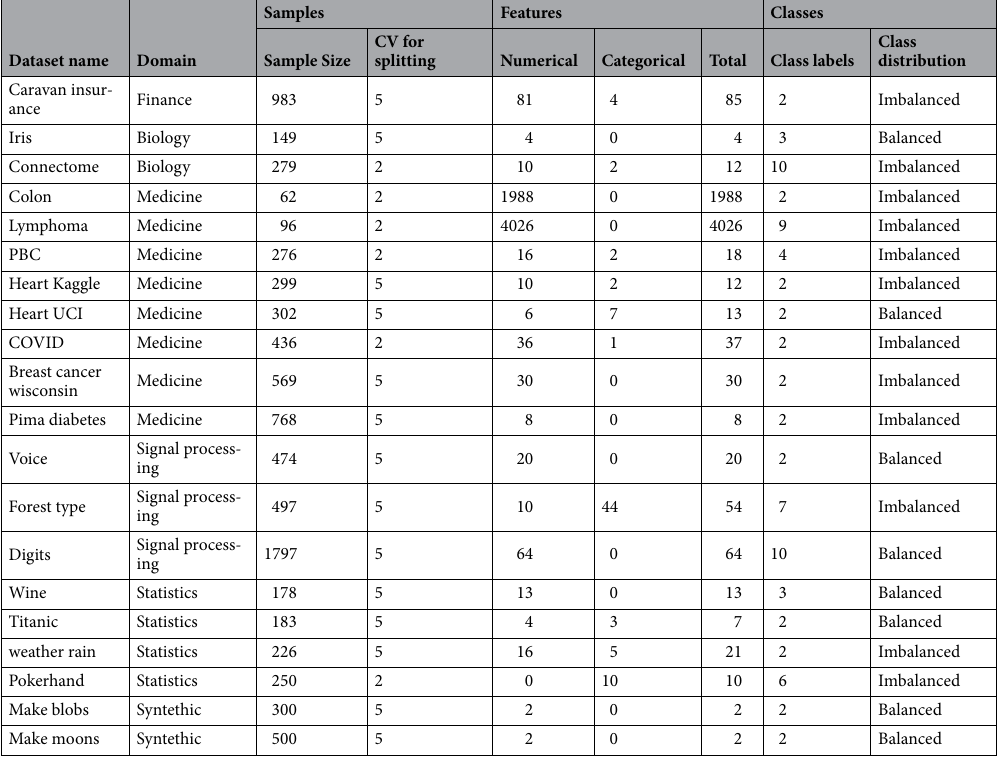
Table 1. The datasets used in the experiments.